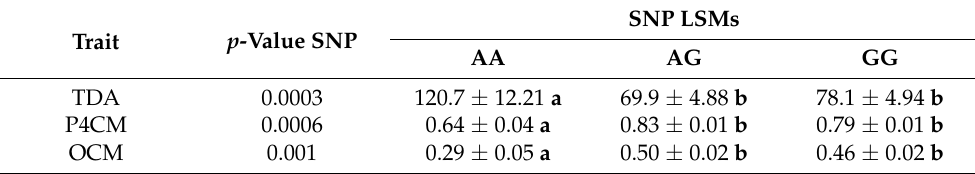
Table 4. Type III test for the SNP located at exon 3 of the CD226 gene on seasonal traits (total days of anoestrous (TDA), oestrous cycling month (OCM) and progesterone cycling month (P4CM)) of Rasa Aragonesa ewes. The least square means (LSMs) and standard errors of alternative genotypes are also shown. Only significant SNPs after Bonferroni correction are shown. Different letters indicate significant differences: a , b : p <